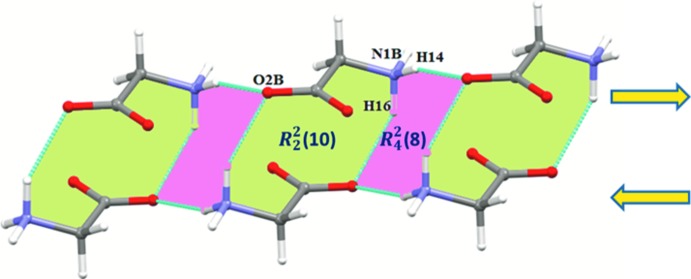
Anti-parallel glycinium arrays showing the formation of alternate (10) and (8) motifs.